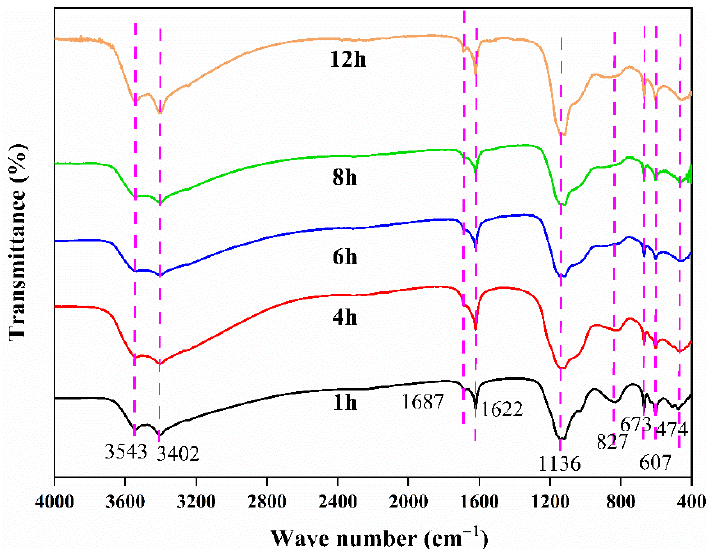
Figure 8. FTIR spectra of the arsenic-bearing precipitates obtained at various reaction times (1,4, 6, 8, and 12 h).